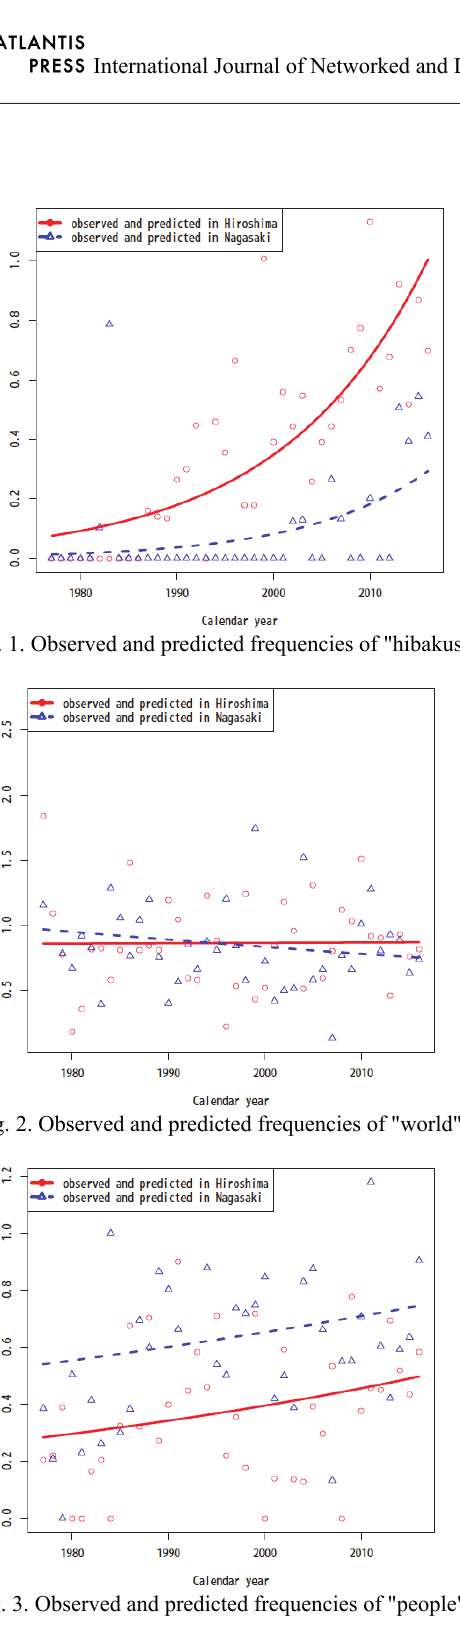
Fig. 6. Estimates and 95% simultaneous CI of regression coefficient in